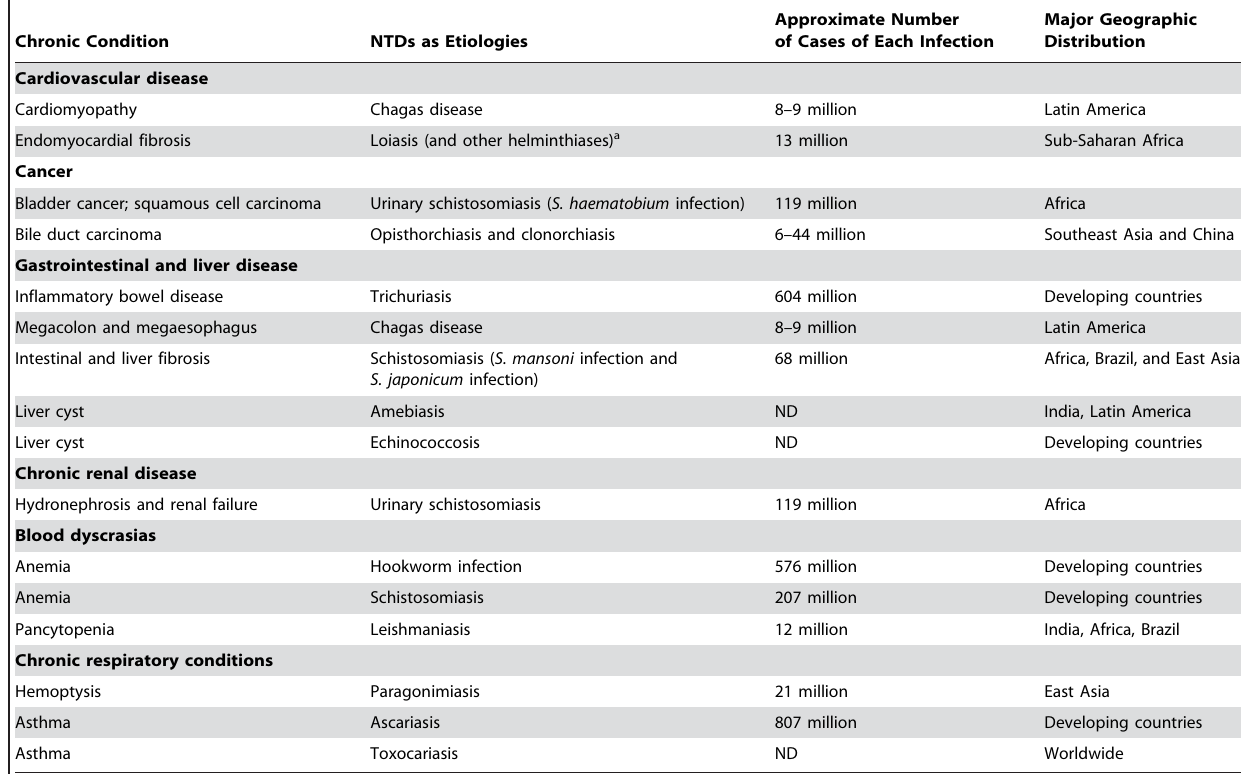
Table 1. CNCD-Like Syndromes Caused by the